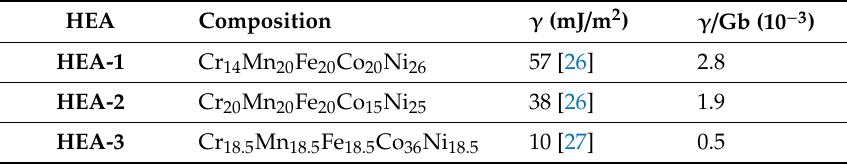
Table 1. Composition of HEAs 1–3 and their stacking fault energies γ . Approximate normalized SFEs γ / Gb have been estimated by taking the shear modulus G and magnitude of the Burgers vector b of the equiatomic Cantor alloy